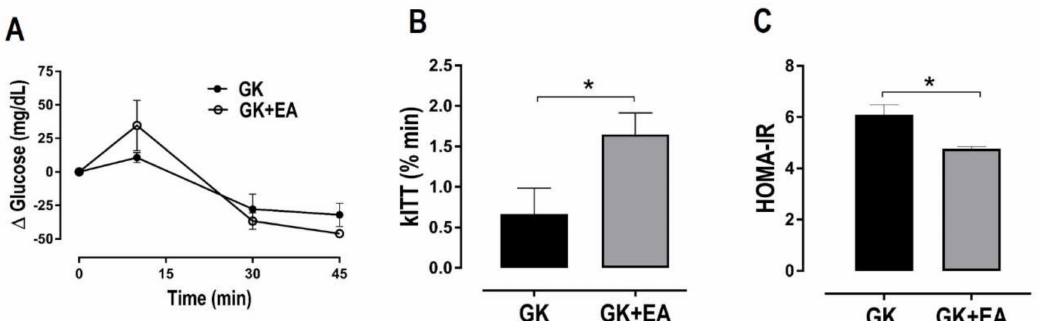
Figure 2. EA treatment enhances insulin sensitivity and reduces insulin resistance in diabetic GK rats. ( A ) Insulin Tolerance Test ( B ) Rate constant for the disappearance of glucose in insulin tolerance test (kITT) and ( C ) insulin resistance index estimation by homeostasis model assessment method (HOMA-IR) were performed in female diabetic GK rats with or without EA (50 mg/kg) treatment for 45 days. Data are presented as mean ± SEM, * p < 0.05, ( n = 8).